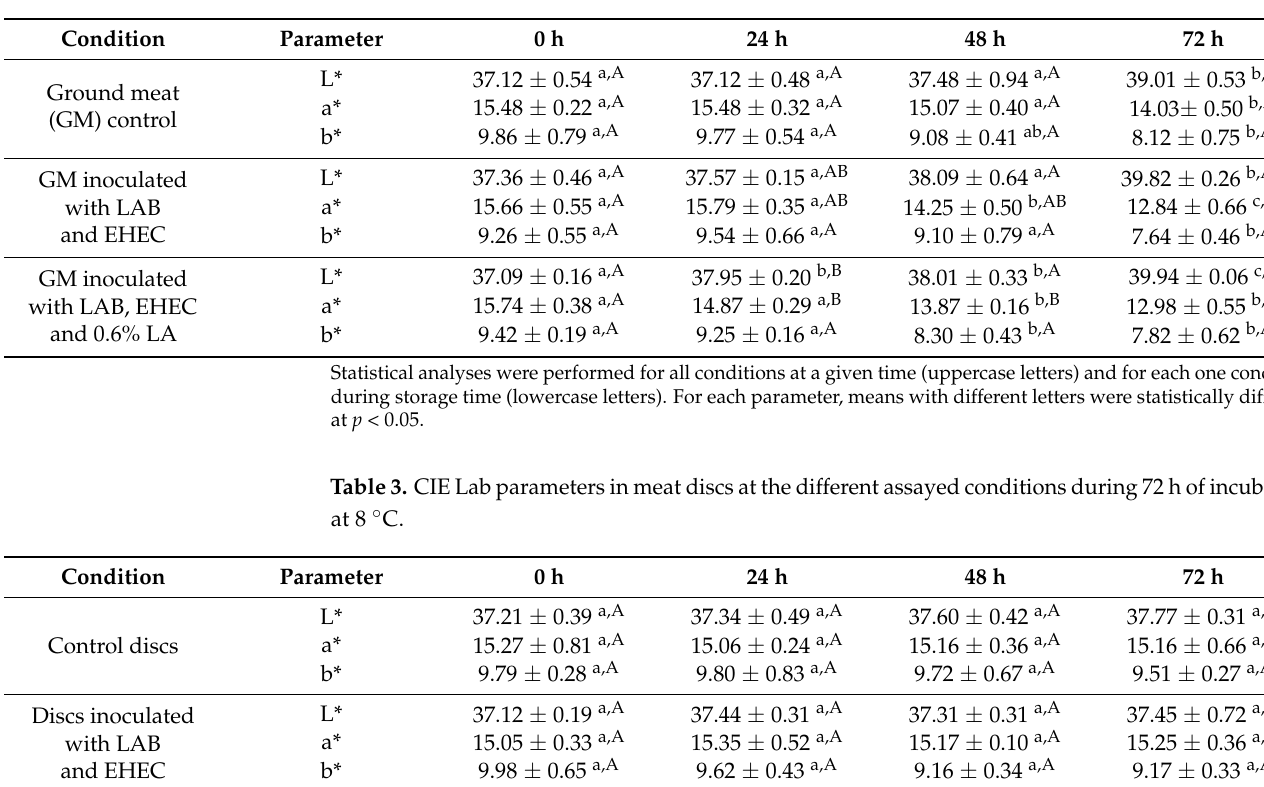
Table 2. CIE Lab parameters in ground meat (GM) at the different conditions assayed during 72 h of incubation at 8 ◦ C.